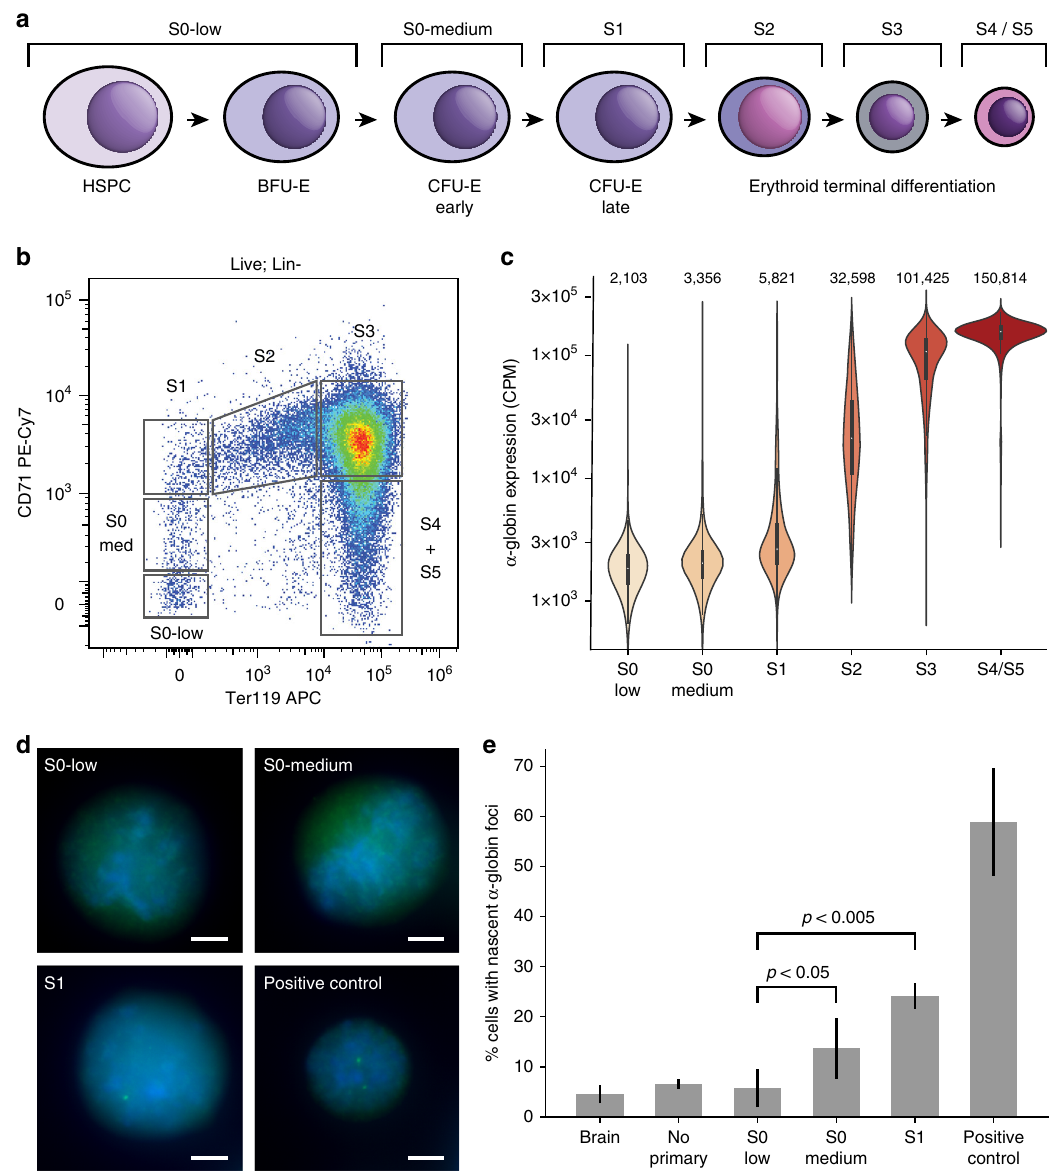
Fig. 3 Expression of α -globin is gradually upregulated during in vivo erythroid differentiation. a Scheme of erythroid differentiation showing the various populations analyzed. b Example FACS plot showing the gating strategy used to isolate erythroid progenitors from mouse fetal liver. c Expression (in counts per million) of α -globin transcripts in each population as determined by single-cell RNA-seq. Mean expression for each population is given at the top of each bar. d Representative RNA-FISH images showing detection of nascent α -globin transcripts in sorted early erythroid progenitors. Scale bar is 3 μ M for each image. e RNA-FISH quanti fi cation, showing the mean ± s.d. of n = 3 independent experiments (except for brain and “ no primary ” negative controls, which have n = 2). P -values were calculated by two-tailed paired t -tests (S0-low vs S0-medium P = 0.041, S0-low vs S1 P = 0.002). Source data are provided as a Source Data fi